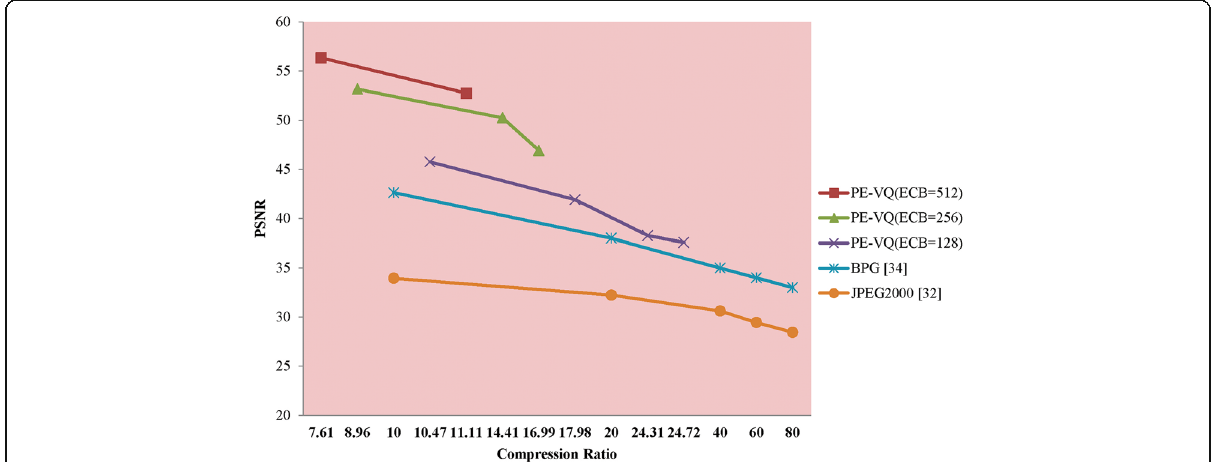
Fig. 19 Comparison of CR and PSNR values of PE-VQ method with existing methods using Peppers